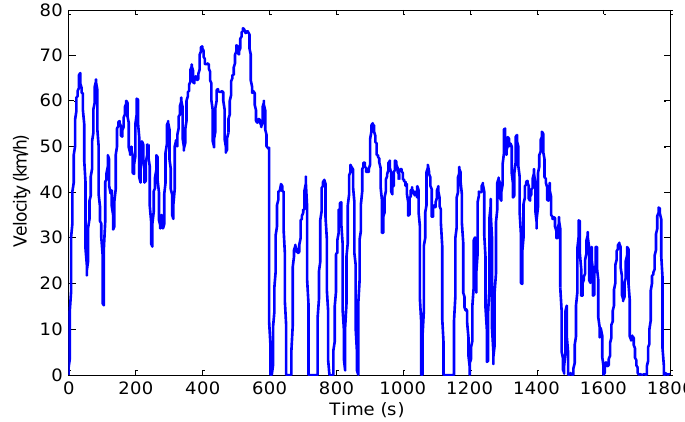
Figure 22. Randomly generated driving cycle from the standard driving cycle library.